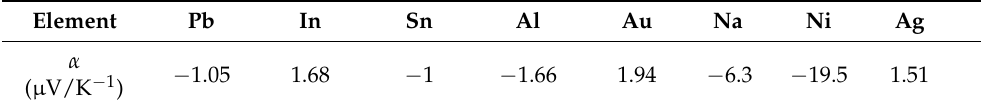
Table 3. Seebeck coefficient α values for various chemical elements (at 300 K) [31].